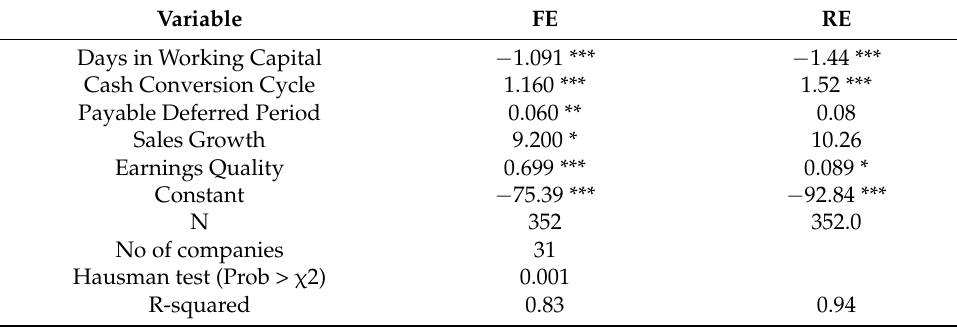
Table 4. Effect of WCM components on